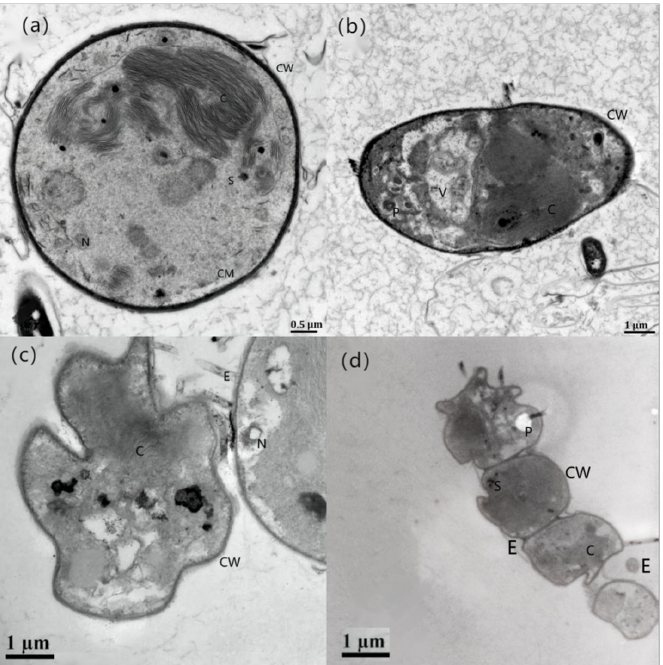
Figure 3. Transmission electron micrographs of Scenedesmus quadricauda : ( a ) cross section of algal cell, HgCl 2 0 mg/L; ( b ) longitudinal section of algal cell, HgCl 2 0 mg/L; ( c ) cross section of algal cell, HgCl 2 0.9 mg/L for 9 days; ( d ) cross section of algal cells, HgCl 2 0.9 mg/L for 9 days. CW: cell wall; CM: plasma membrane; C: chloroplast; P: nucleolar phosphoprotein; N: nucleus; V: vacuole; E: exuded intracellular substances; S: vesicles.